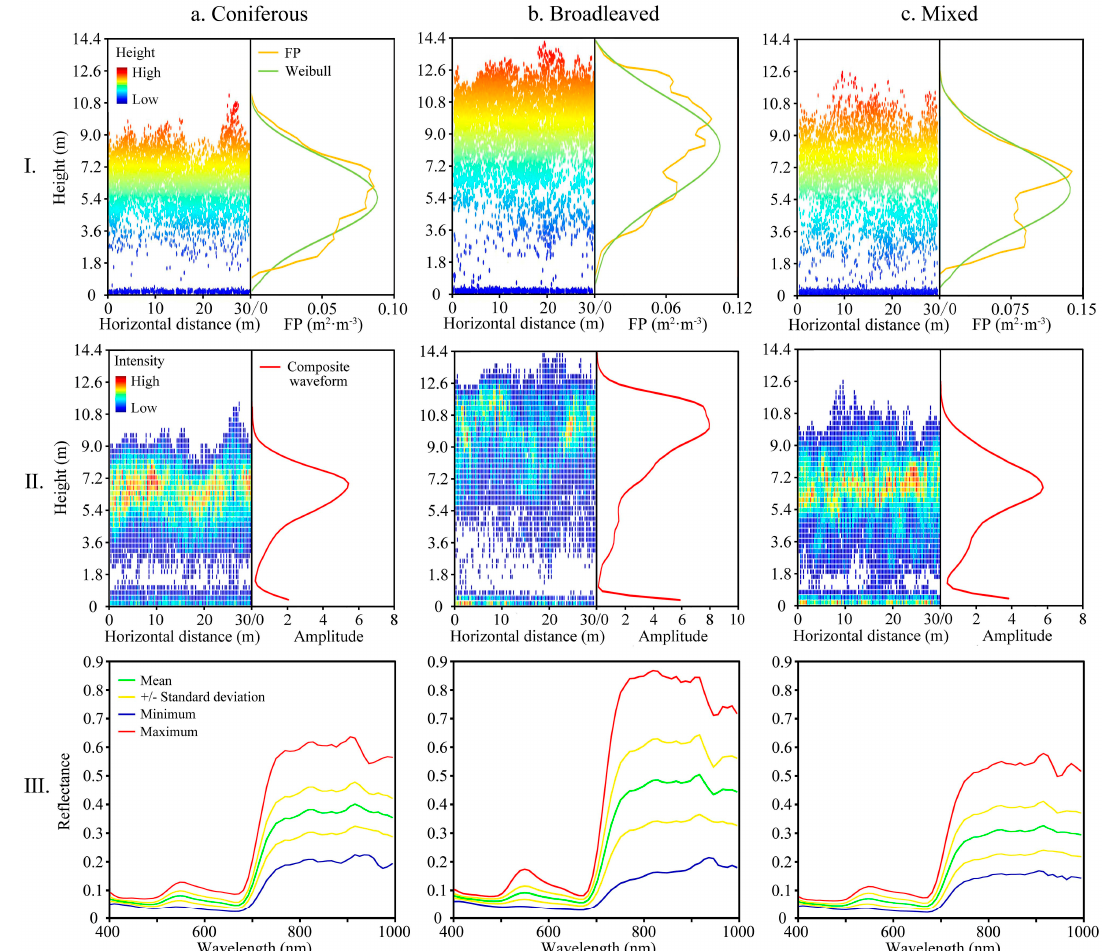
Figure 4. LiDAR point cloud profiles ( I left), apparent foliage profiles (FP) ( I right), Weibull distributions ( I right), intensity of energy profile ( II left), composite waveform ( II right), and spectral reflectance ( III ) derived from the plots of coniferous forest (column 1), broadleaved forest (column 2) and mixed forest (column 3).